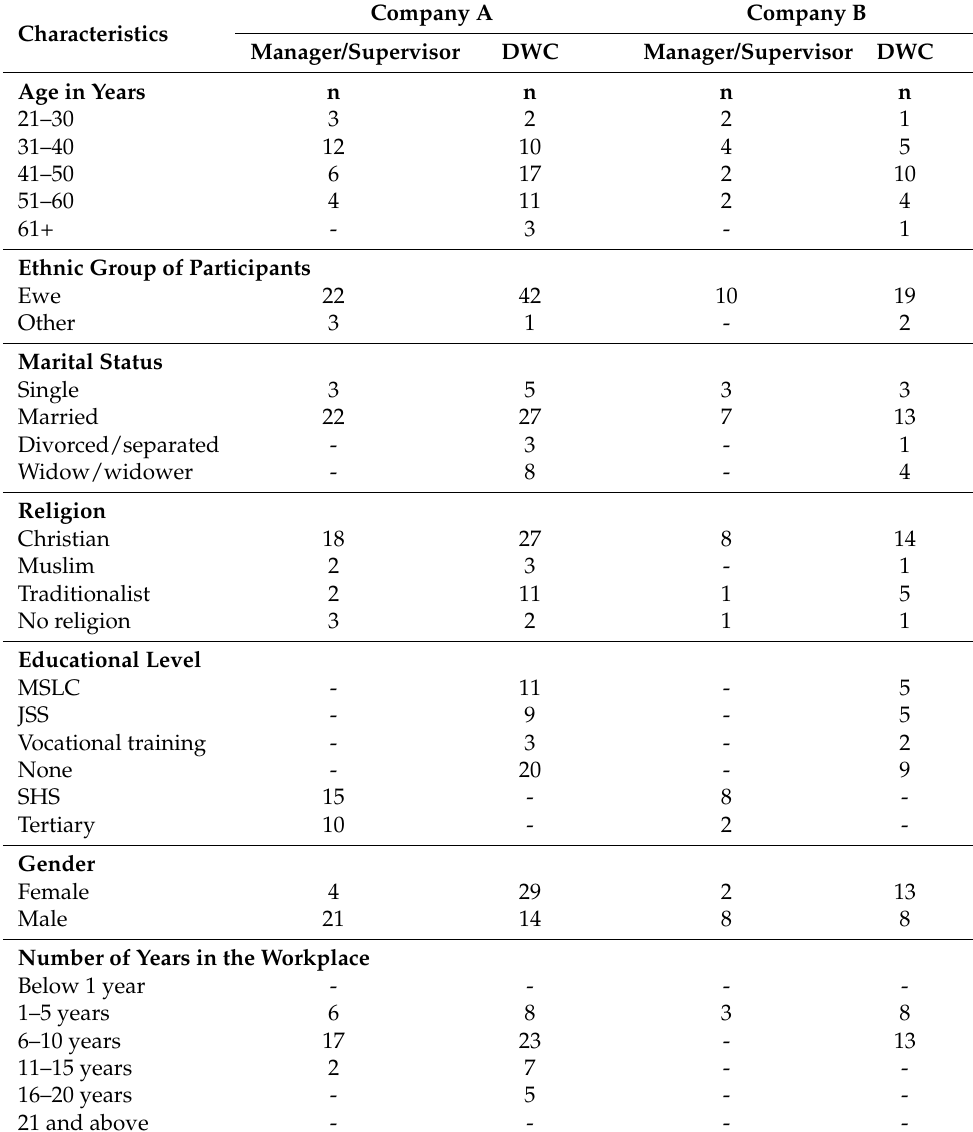
Table 3. Demographic and socio-economic characteristics of the study